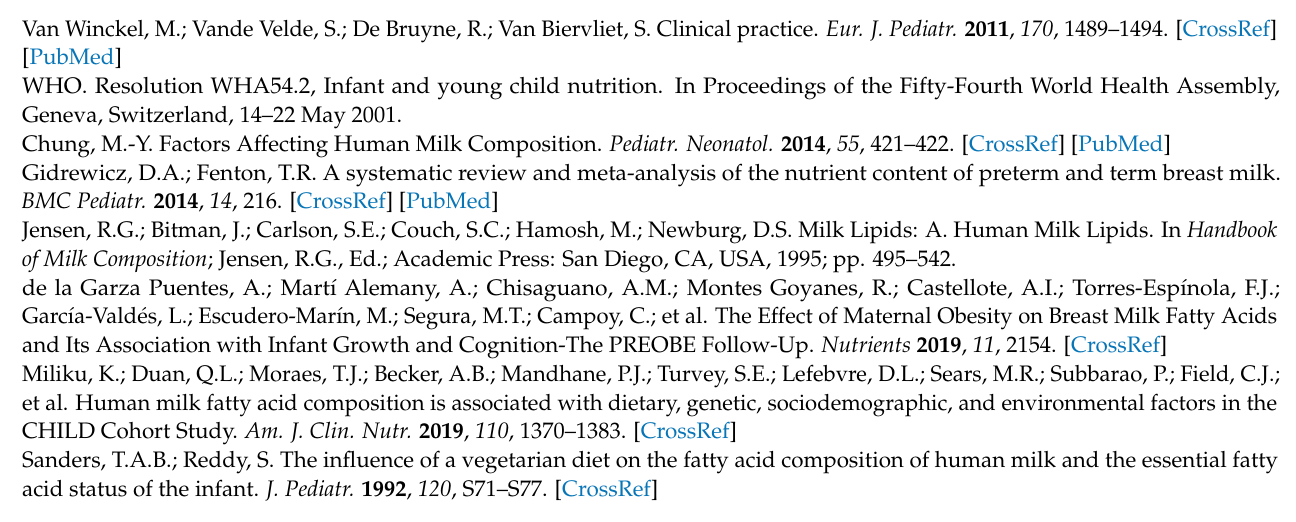
Table S3: Results of GC-MS analysis for individual FAs in the validation set; Table S4: Results of GC-MS analysis for sum parameters in the validation set; Table S5: Selected options for the Analytical GREEnness evaluation and attributed